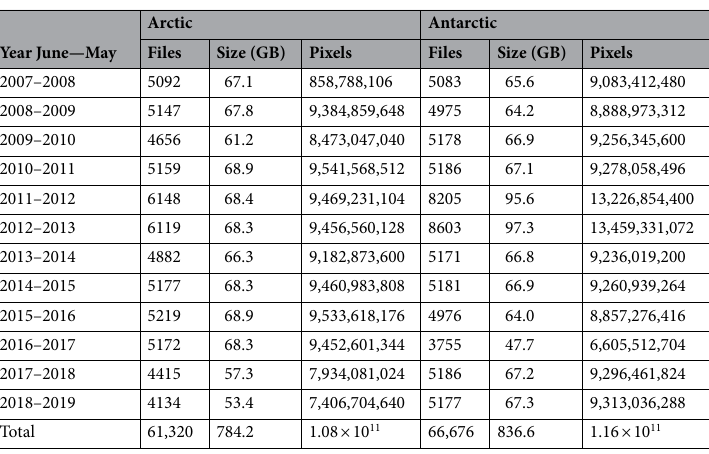
Table 2. Statistics of analyzed